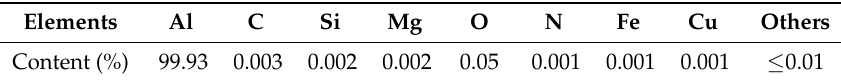
Table 1. The chemical composition of aluminium